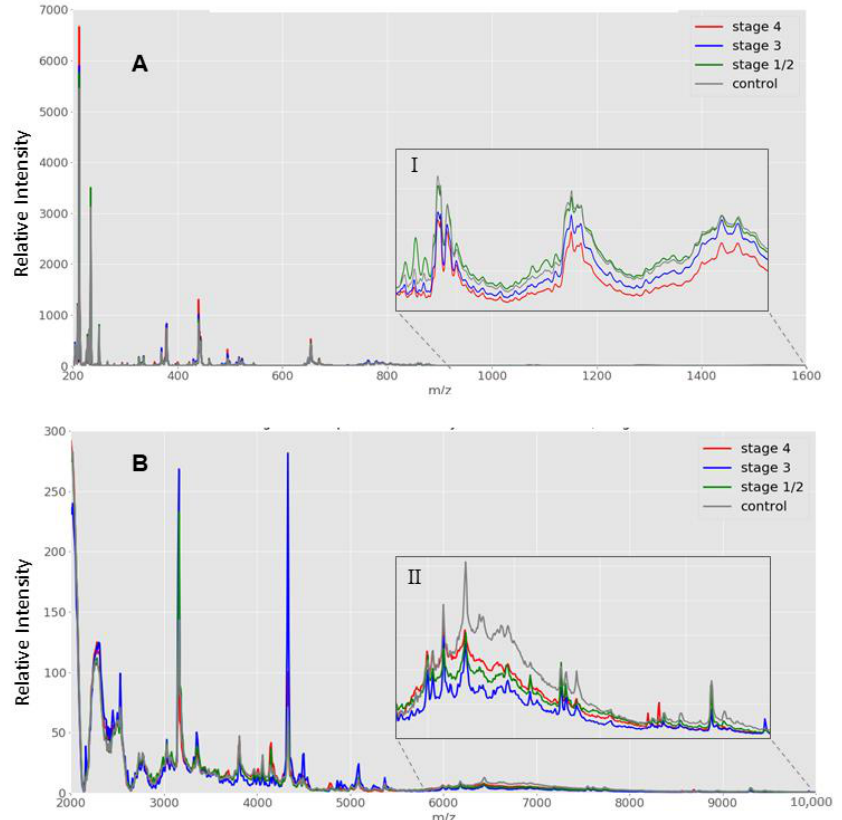
Figure 1. Averaged mass spectra of serum samples from women diagnosed with ovarian cancer at different stages and controls. ( A ) Spectrum generated with CHCA matrix. ( B ) Spectrum generated with SA matrix. Red indicates averaged mass spectra of women with ovarian cancer at stage 4, blue at stage 3, and green at early stages (stage 1 and 2). Gray spectrum indicates averaged mass spectrum of women with no ovarian cancer. Relative intensities are expressed in ppm. Lower-intensity region spectrum zooms from regions within dashed lines are depicted in the inset spectra I and II for CHCA and SA matrix,